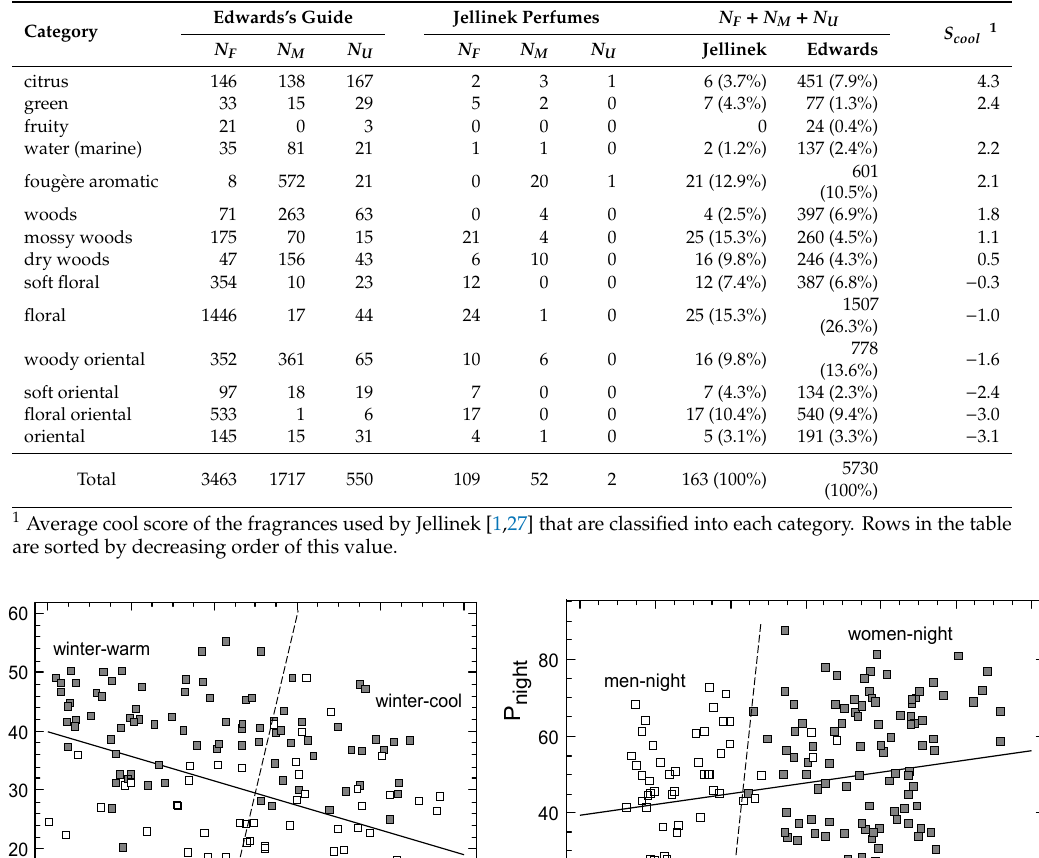
Table 5. Number of fragrances ( N F : feminine, N M : masculine, N U : unisex) listed under each category of the directory compiled by Edwards in 2008 (24th edition) and a classification of the 163 perfumes used by Jellinek [1,27] that are contained in this guide.